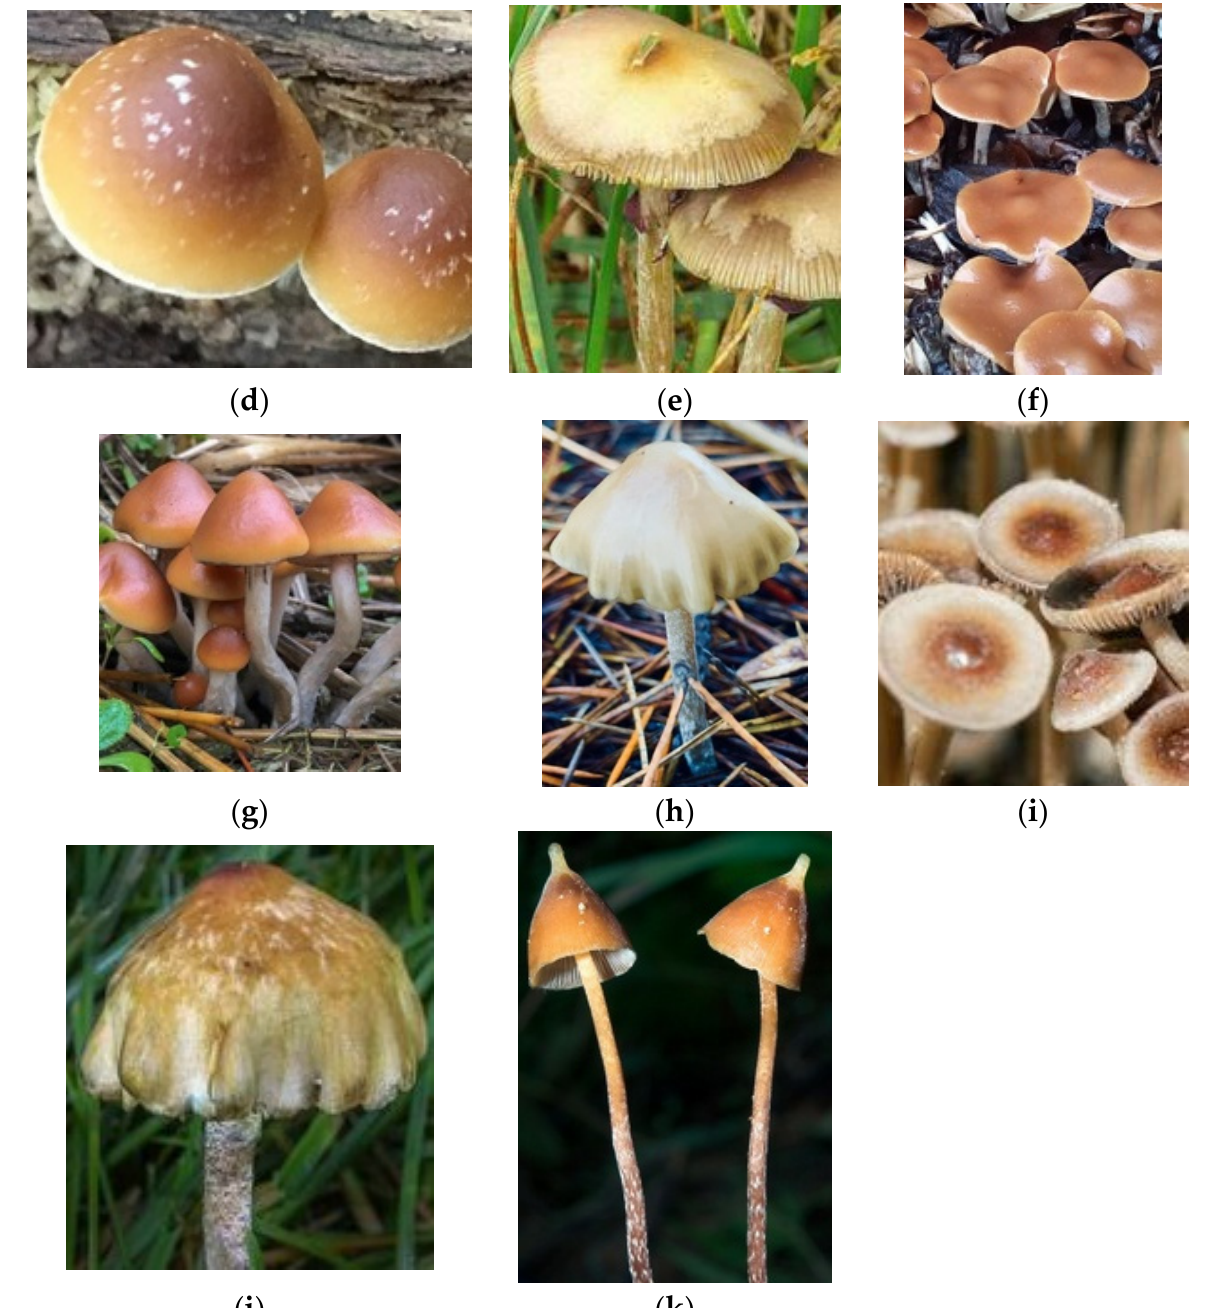
Figure 3. Examples of Magic mushrooms (psilocybin-producing mushrooms). ( a ) Psilocybe cubensis (Earle) Singer a.k.a Stropharia cubensis [131]. ( b ) Psilocybe caerulescens Murrill (a.k.a. Landslide Mushrooms, Derrumbes) [132]. ( c ) Psilocybe mexicana R. Heim (a.k.a. Teonanacatl, Pajaritos) [133]. ( d ) Psilocybe caerulipes (Peck) Sacc. (a.k.a Blue Foot Mushroom) [134]. ( e ) Psilocybe stuntzii Guzmán and J. Ott (a.k.a. Blue Ringer Mushroom, Stuntz’s Blue Legs) [135]. ( f ) Psilocybe cyanescens Wakef. (a.k.a. Wavy Caps) [136]. ( g ) Psilocybe azurescens Stamets and Gartz (a.k.a Flying Saucer Mushrooms)’ [137]. ( h ) Psilocybe pelliculosa (A.H. Sm.) Singer and A.H. Sm. [138]. ( i ) Psilocybe tampanensis Guzmán and Pollock (a.k.a Magic Truffles, Philosopher’s Stone [139]. ( j ) Psilocybe baeocystis Singer and A.H. Sm. [140]. ( k ) Psilocybe Hoogshagenii R. Heim nom. inval . (a.k.a. Little Birds of the Woods) [141] .